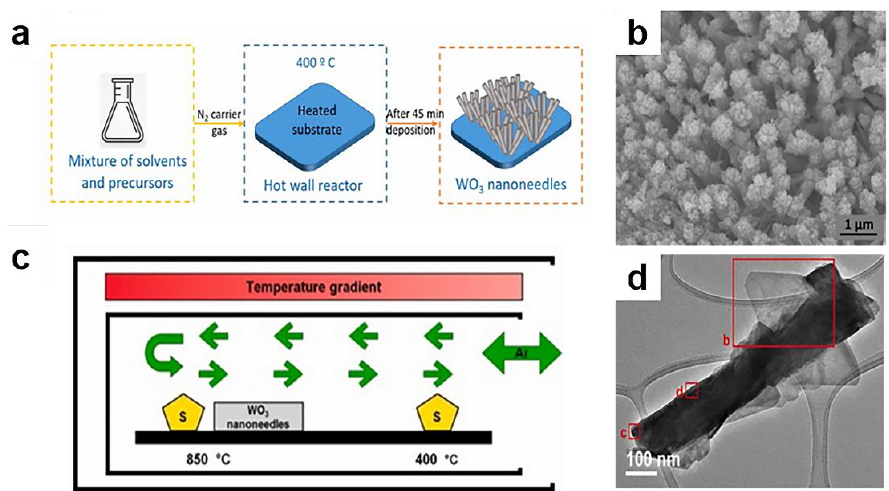
Figure 13. ( a ) AA-CVD synthesis of WO 3 nanomaterials; ( b ) CVD synthesis of WS 2 nanomaterials; ( c ) SEM images of WO 3 nanorods; ( d ) TEM image of WS 2 nanoneedles. [129] Copyright © 2021 Elsevier B.V. and Sensors and Actuators B: Chemical.